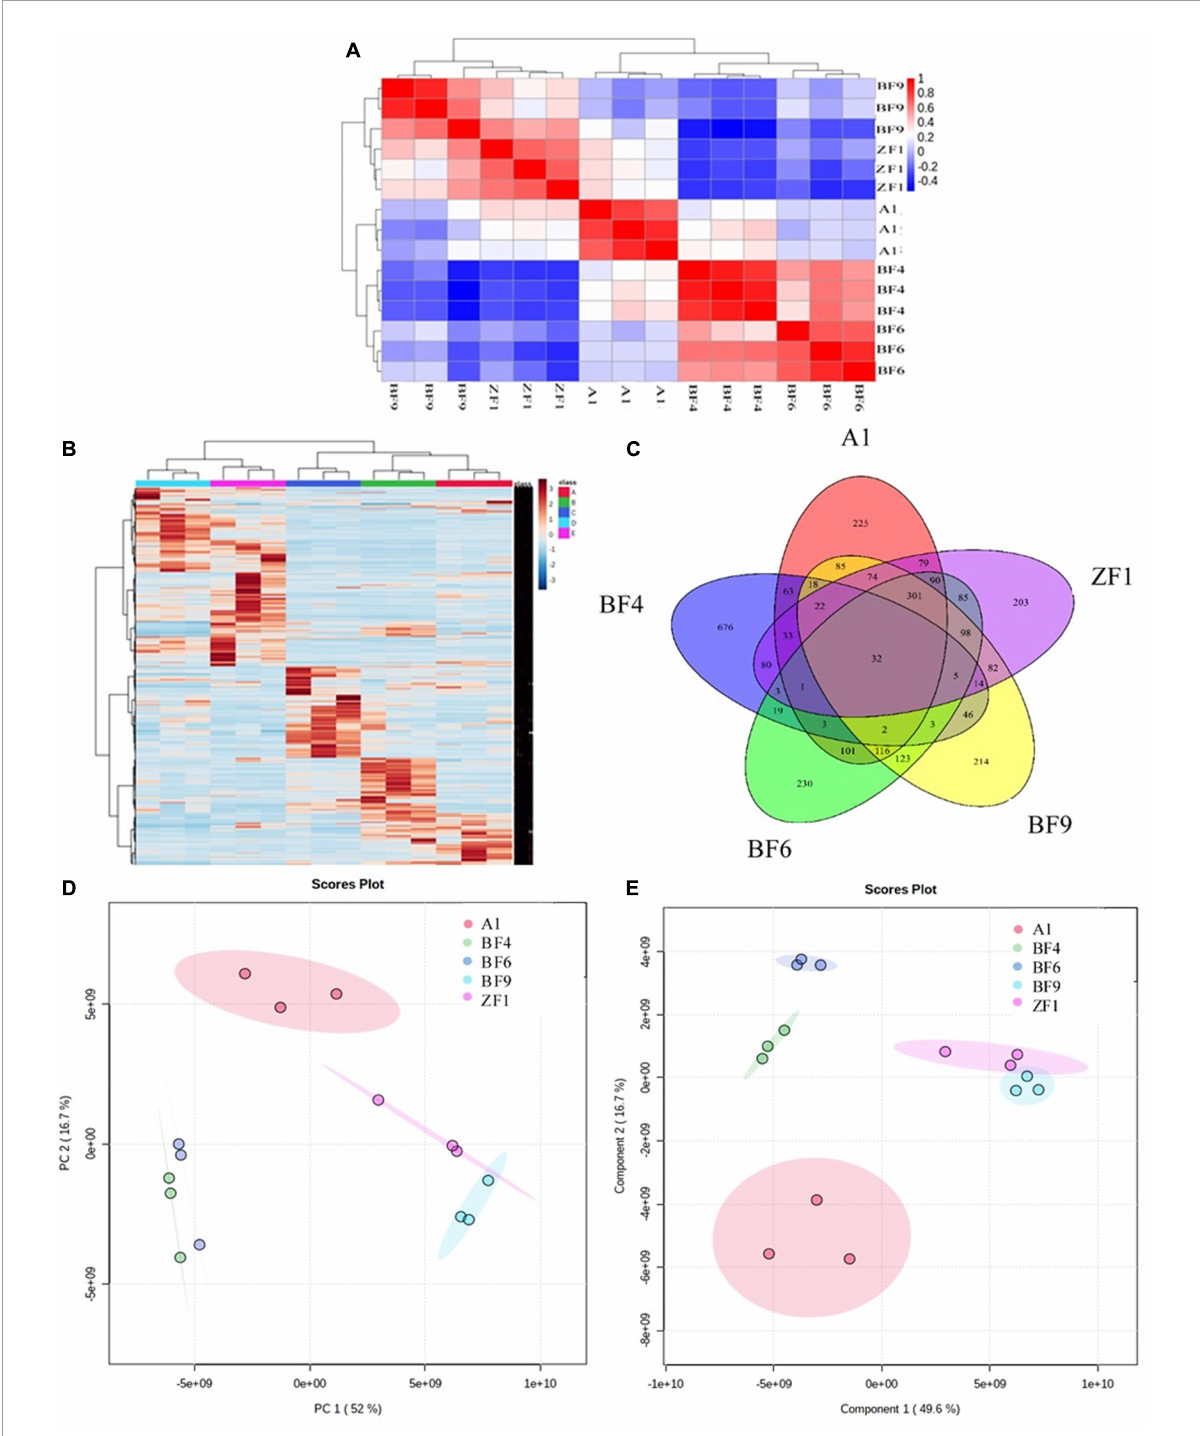
FIGURE4 Metabonomic analysis of Streptomyces co-culture in five different culture mediums [ (A) , correlation analysis; (B) , metabolite clustering analysis; (C) , Venn diagram; (D) , PCA analysis; and (E) , PLS-DA